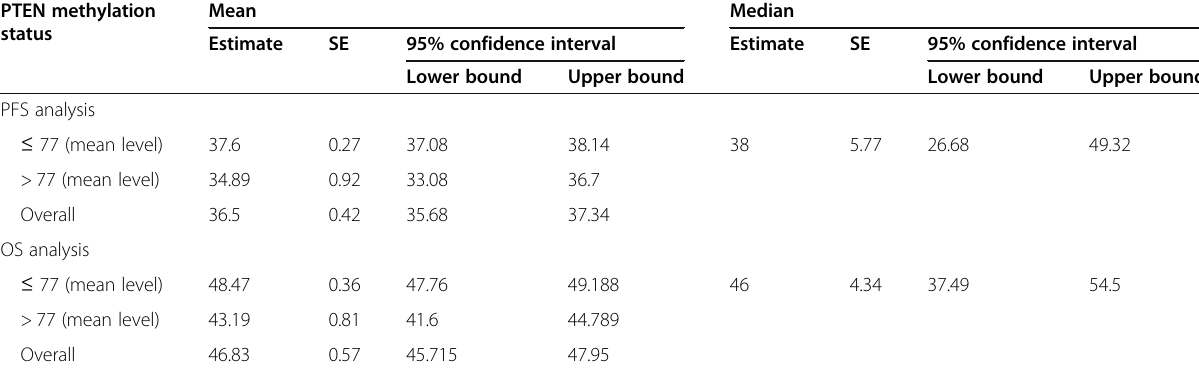
Table 5 Survival analysis of breast cancer patients according to PTEN methylation status